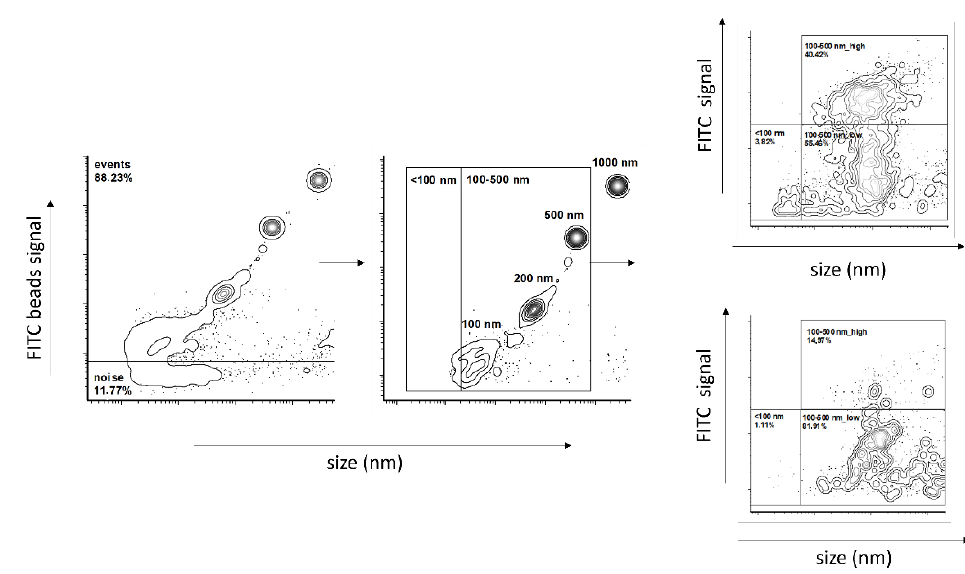
Figure 8. Flow cytometry gating strategy.